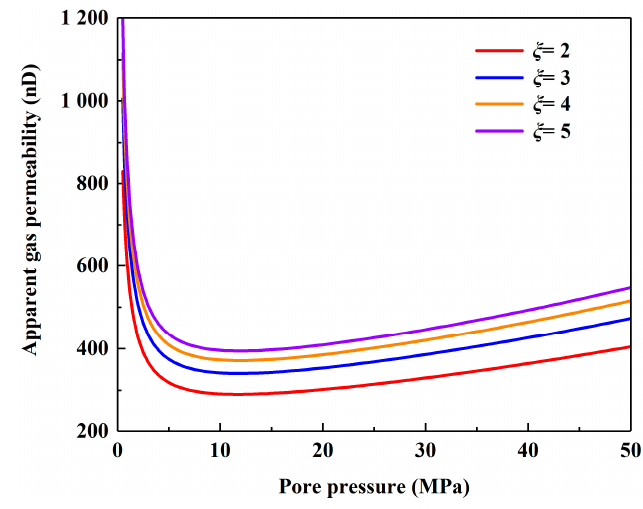
Figure 12. The AGP in inorganic pore with different aspect ratios ( h = 30 nm, S w = 0.1).